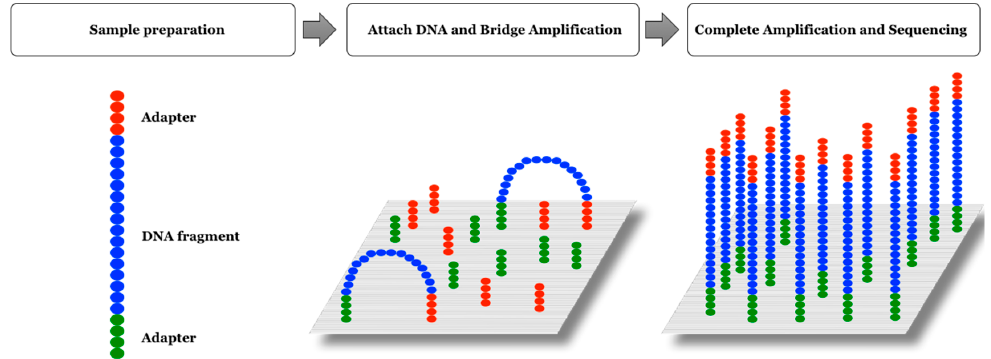
Figure 9. Illumina sequencing. The fragments are attached to primers immobilized on a solid surface, performing a bridge-amplification and generating clusters of DNA with identical molecules.